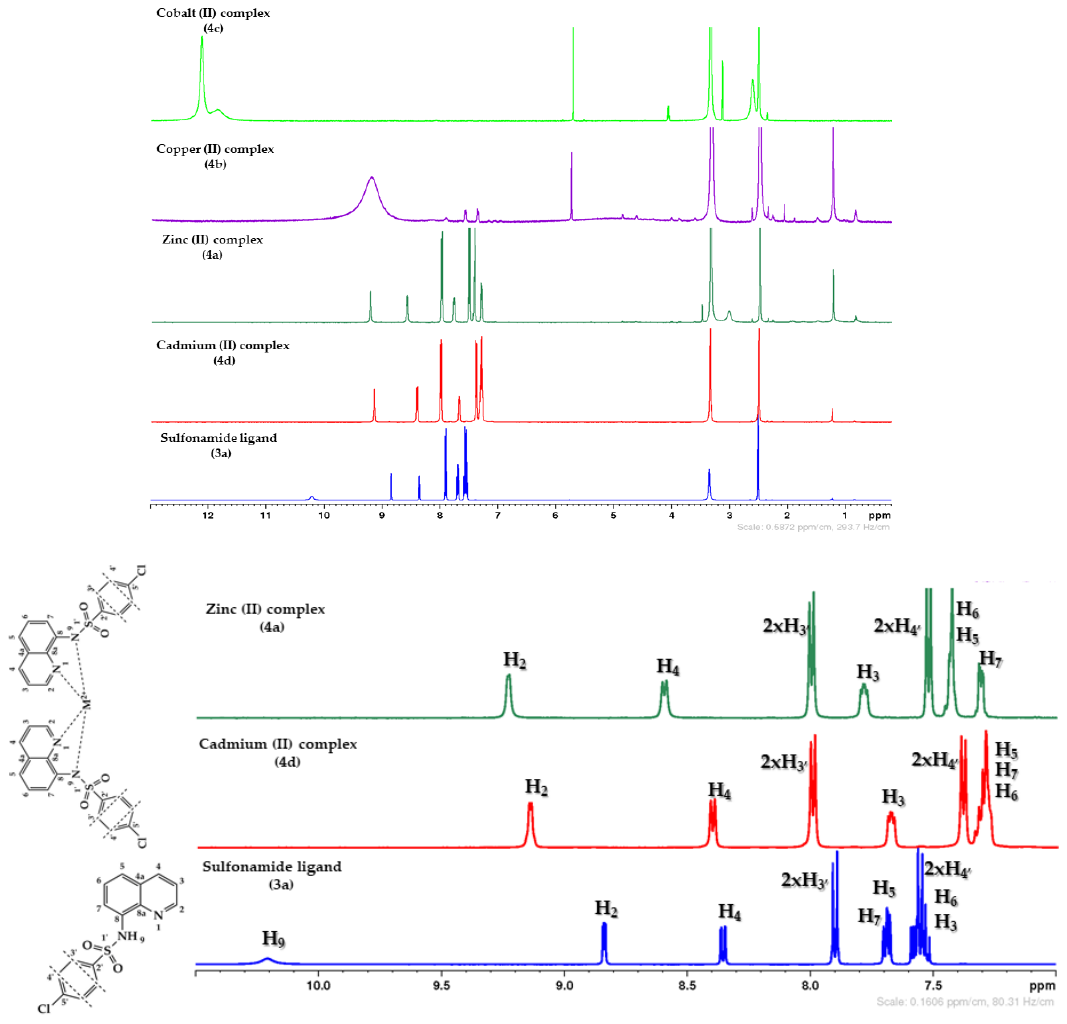
Figure 2. 1 H-NMR spectra for sulfonamide ligand ( 3a ) and its complexes ( 4a – d ). At the bottom part of the image is represented a detail of aromatic zone (7–11 ppm).